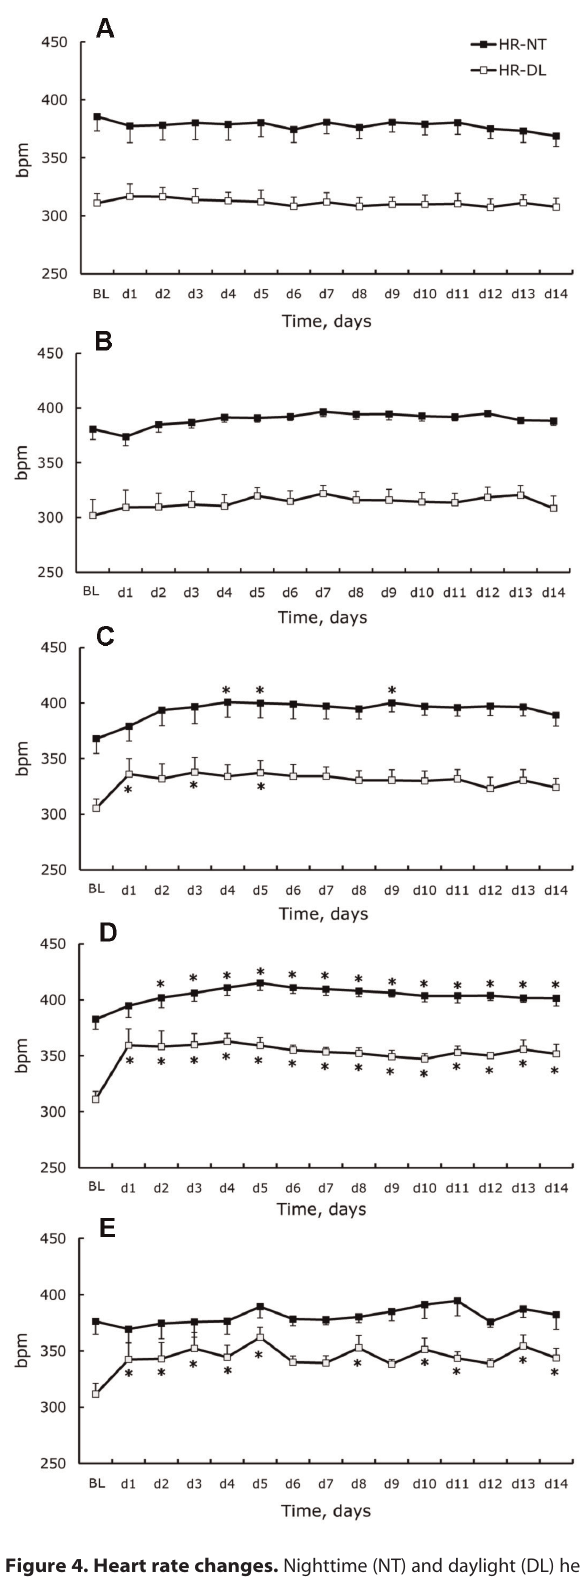
Figure 4. Heart rate changes. Nighttime (NT) and daylight (DL) heart rate measured in standard cages (BL) and during 14 days (d1–d14) for control ( A ), isolated-control ( B ), isolated ( C ), attached ( D ), and unloaded ( E ) rats. Data are given as a mean 6 SEM. *- P , 0.05 versus basal level (BL).